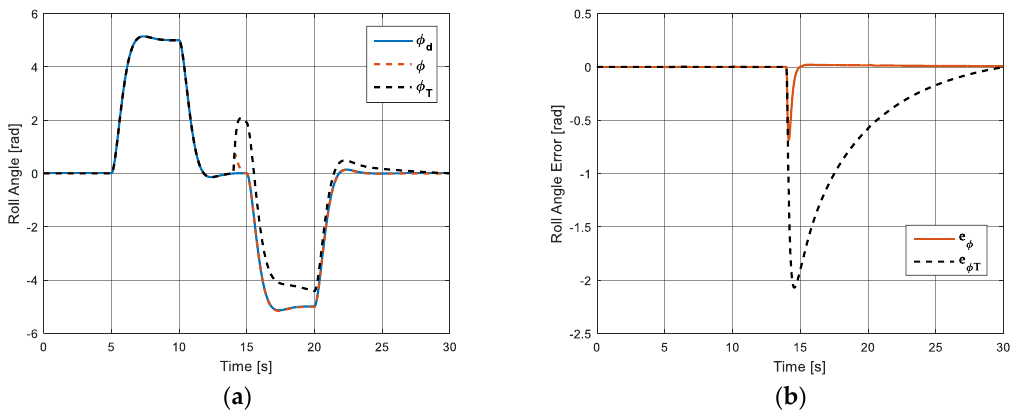
Figure 6. Comparison of tracking performance between NASMC and MASMC with 50% LoCE in actuator 2: ( a ) Roll angle; ( b ) tracking error.